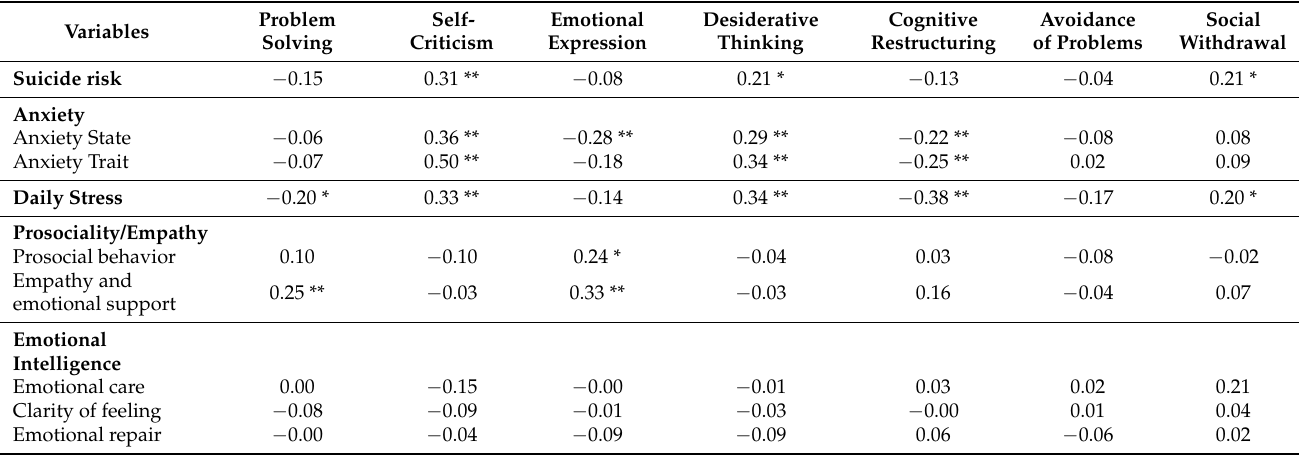
Table 4. Correlations between coping strategies and suicidal risk, anxiety, daily stress, prosociality, and perceived emotional intelligence.